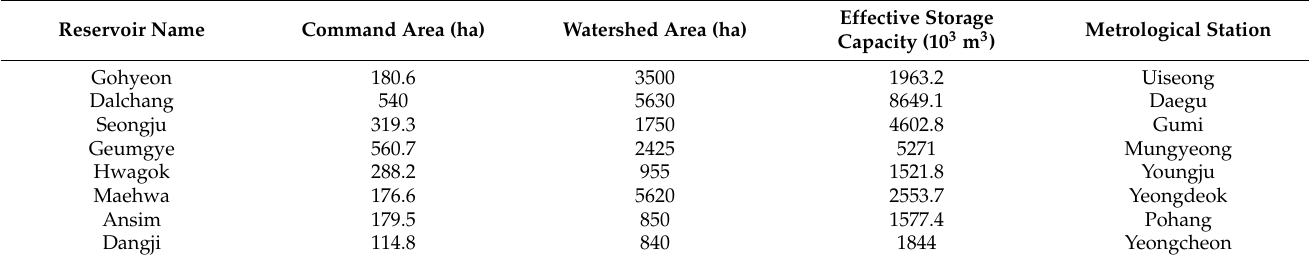
Table 3. Selected reservoirs for the estimation of irrigation water